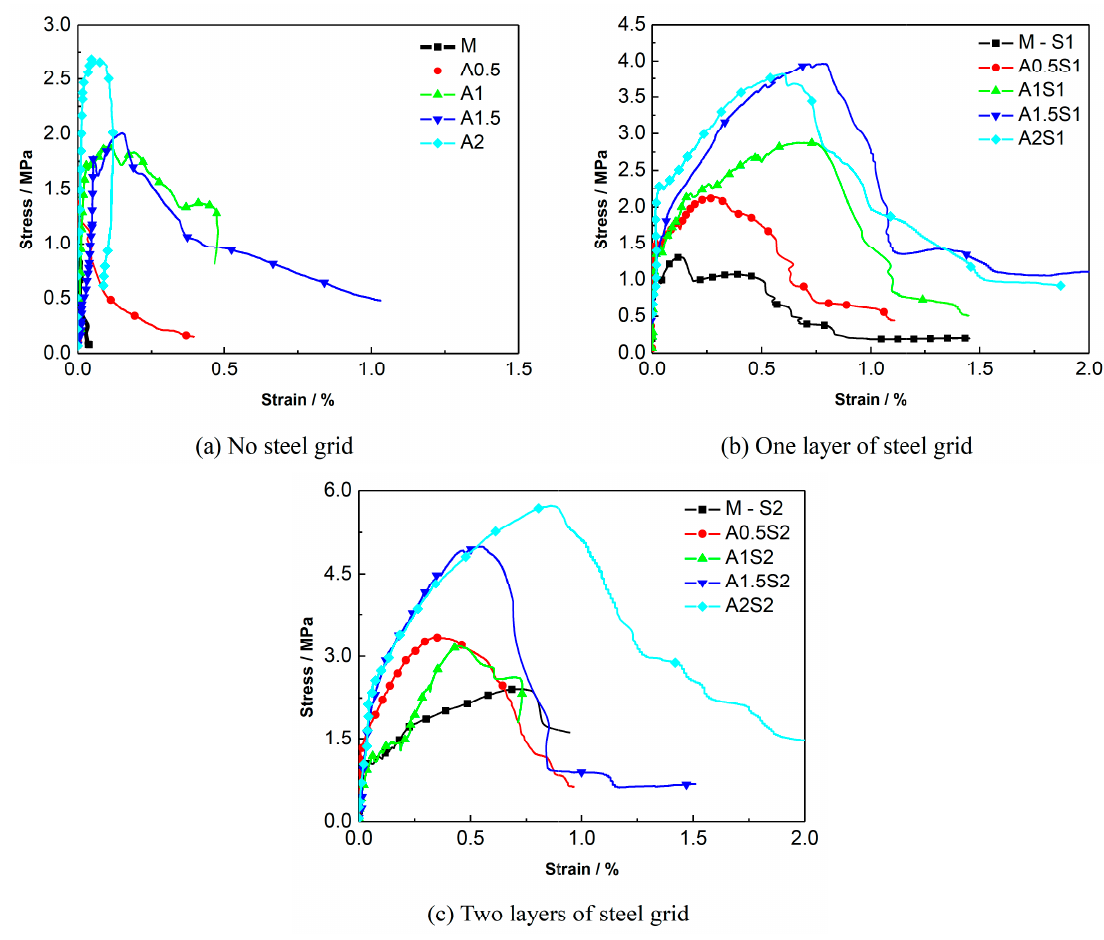
Figure 7. Comparison of stress-strain curves of ECC specimens with di ff erent PVA fiber volume fractions. ( a ) No steel grid; ( b ) one layer of steel grid; ( c ) two layers of steel